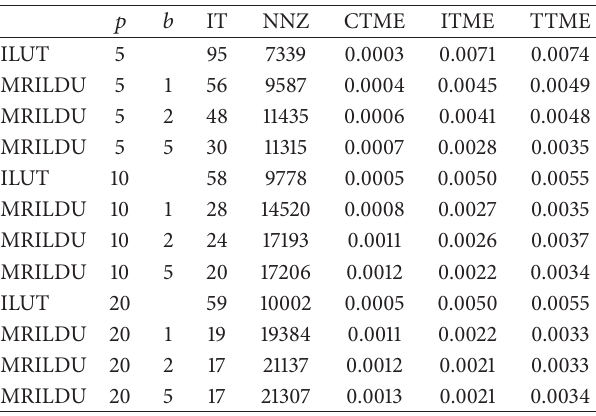
Table 10: Iteration results for matrix pores 2.